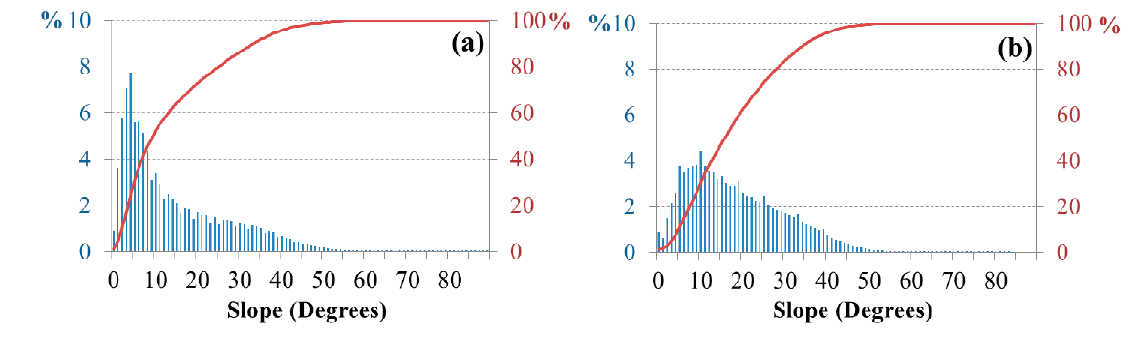
Figure 2. Slope values distribution over the Tibetan Plateau ( a ) and the study area ( b ), expressed as percentage per slope gradient (histogram) and cumulated percentage (red line).